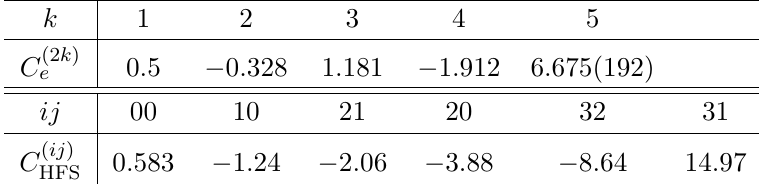
Table 3 . Known coefficients of mass-independent corrections to electron anomalous magnetic moment and to positronium hyperfine